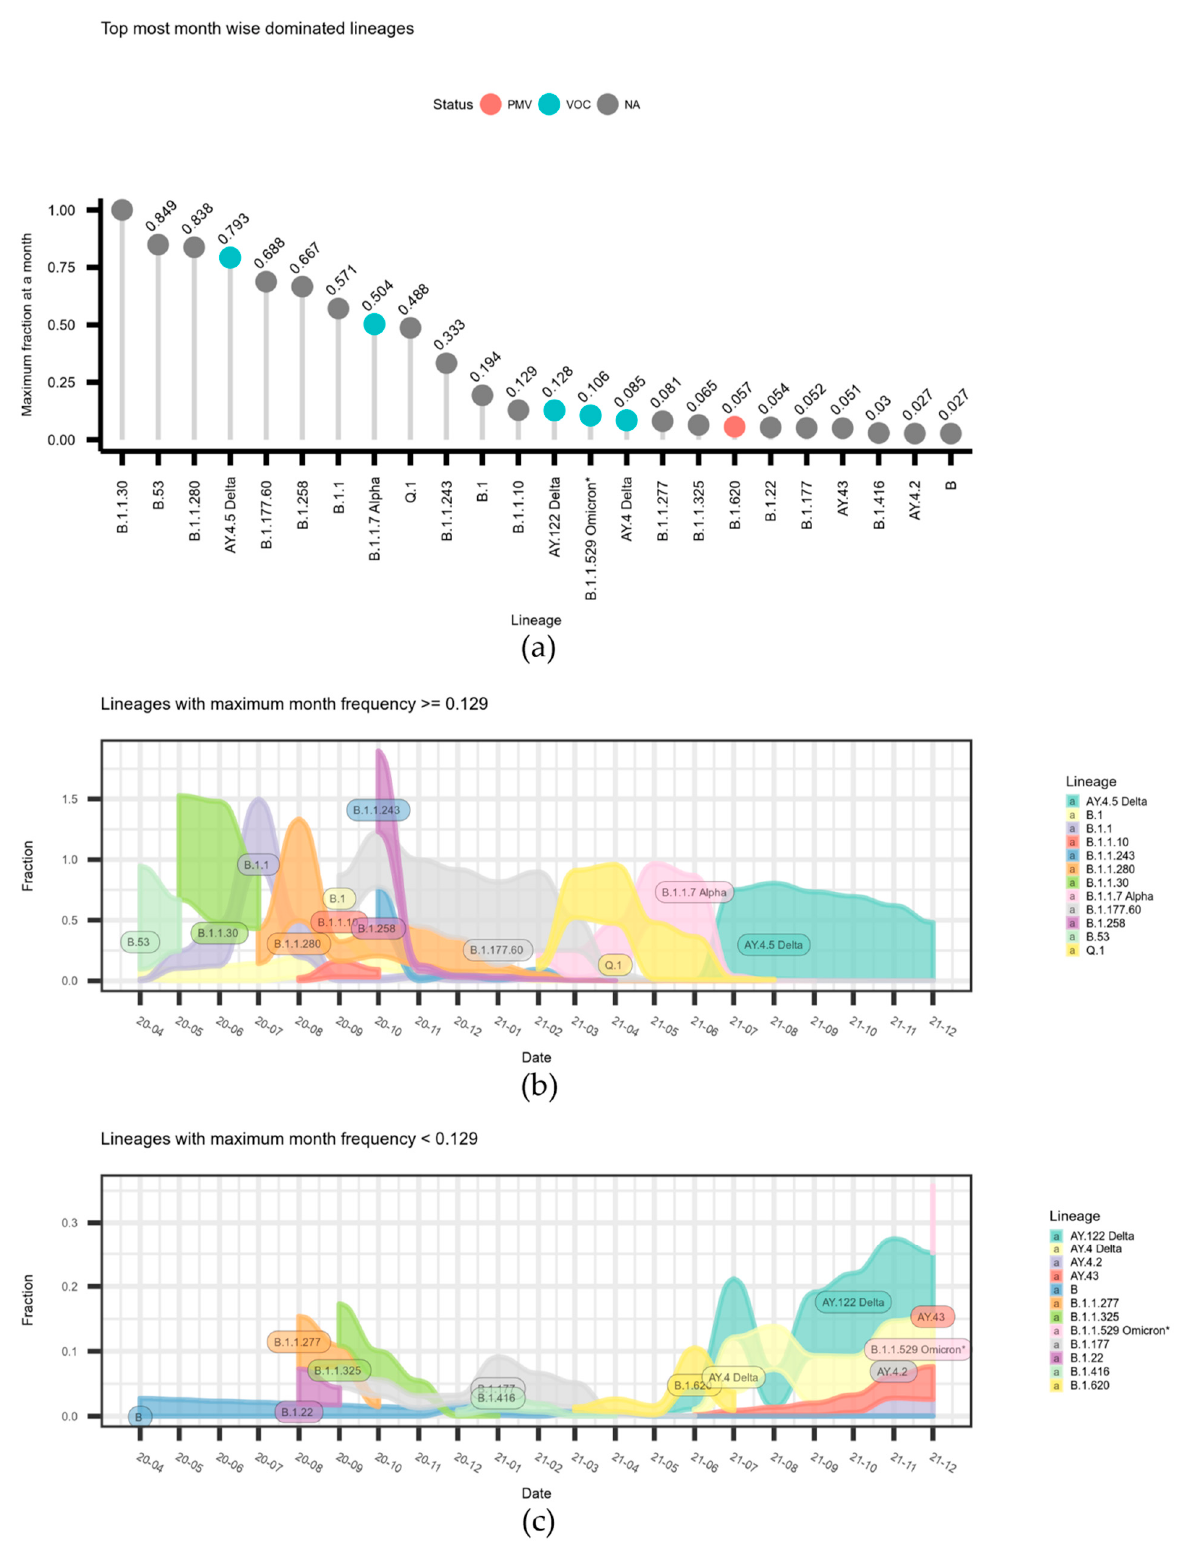
Figure 2. Month-wise dominating lineages (by the end of 2021). ( a ) The lineages ordered in decreasing order based on a maximum monthly frequency in the GISAID data. Top 24 most dominating month-wise lineages are shown. ( b ) The dynamics of the 12 most month-wise frequent lineages. ( c ) The dynamics of the 13–24th most month-wise frequent lineages.